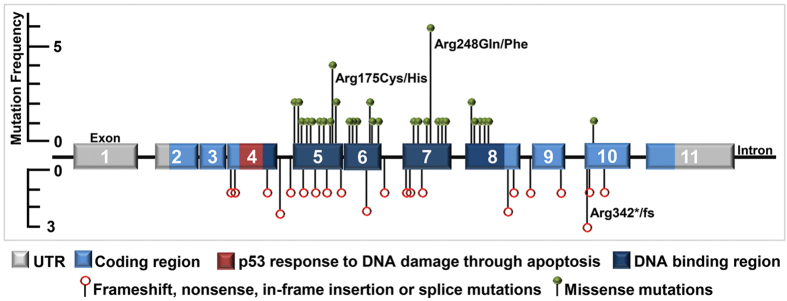
Distribution of TP53 mutations.Grey exons mark the un-translated regions (UTR), light blue exons denote the coding regions, while dark blue exons within the coding region correlate with the DNA binding domain. The dark red region marks the p53 response to DNA damage through apoptosis area. Intronic areas are shown by the black line joining exons. All 68 mutations identified in this study are displayed as lollypop symbols, with missense mutations above the gene marked as green circles, while all ‘other’ mutation types (nonsense, frameshift, in-frame insertion and splice site) are displayed below the gene as open red circles. Mutations occurring more than once are indicated.